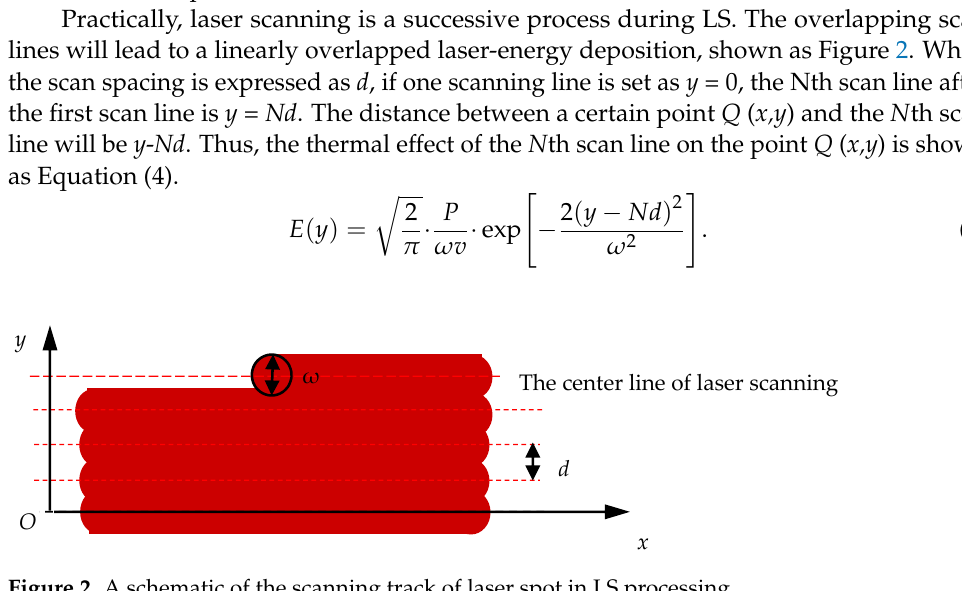
Figure 2. A schematic of the scanning track of laser spot in LS processing.